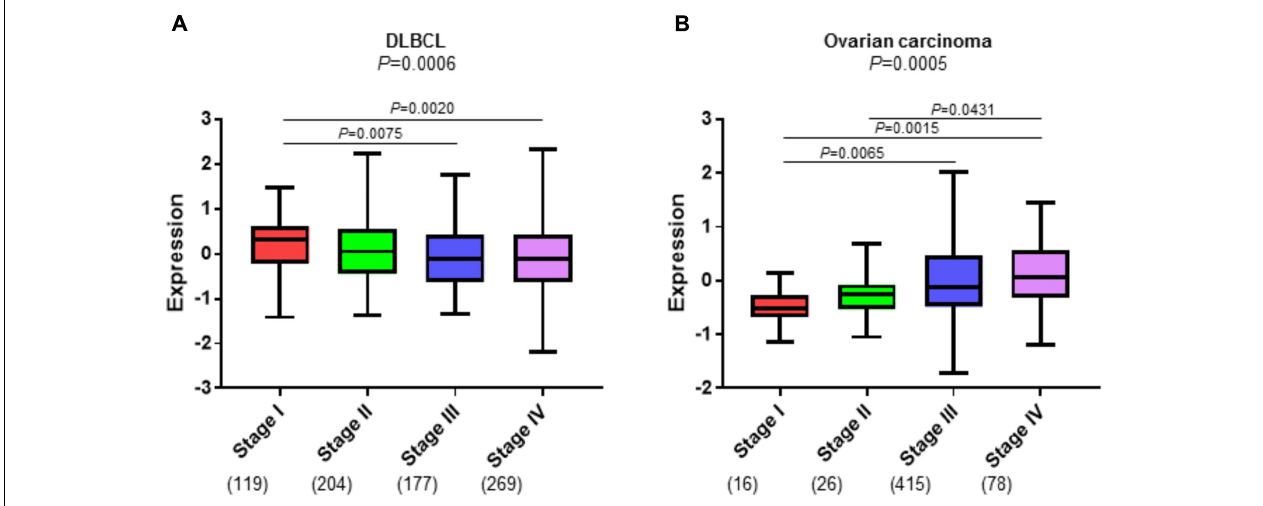
FIGURE 3 | CAFs have an inverse association with tumor stage in DLBCL and ovarian carcinoma. Enrichment of the DLBCL stromal-1 gene signature in progression stages I-IV in (A) three DLBCL microarray datasets (GSE10846, GSE87371, and GSE4475) that were combined into one dataset, and (B) The Cancer Genome Atlas (TCGA) ovarian carcinoma dataset (https://cancergenome.nih.gov). The gene signature enrichment analysis was performed using the R2 Genomics Analysis and Visualization Platform (https://hgserver1.amc.nl). The y axis shows relative enrichment of the DLBCL stomal-1 gene signature. The x axis shows tumor stage. The number of samples for each tumor stage is indicated in parentheses.